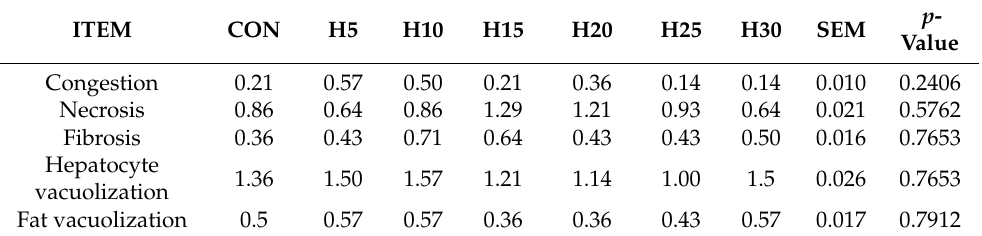
Table 5. Histological assessment of liver samples in Siberian sturgeon fed experimental diets contain- ing increasing shares of black soldier fly full-fat larvae